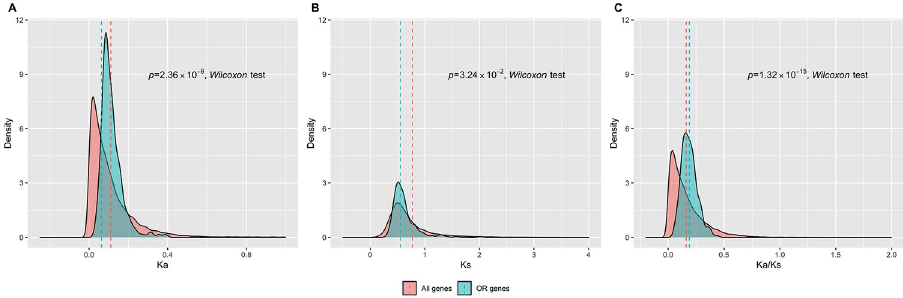
Fig 1. The human functional OR genes evolved relatively faster than the genome average. Comparison of Ka (A), Ks (B) and Ka/Ks (C) between human functional OR genes and the rest of the genes in the human genome ” .